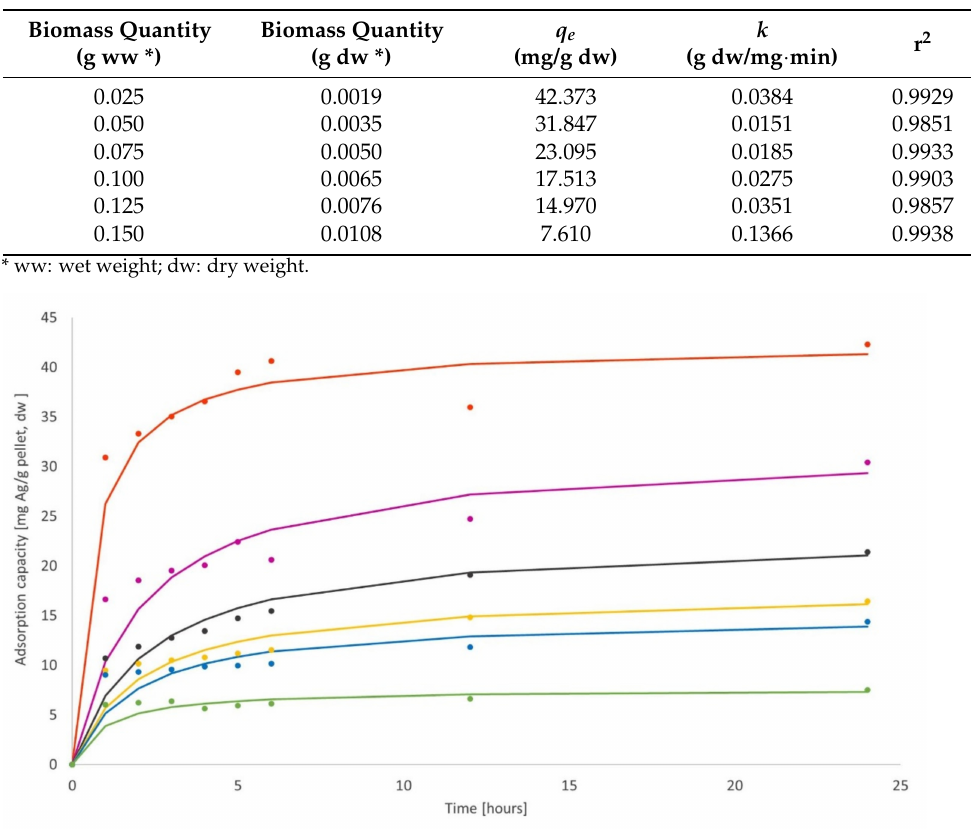
Table 2. Parameters of the pseudo-second-order model kinetic model adjusted to the Ag biosorption on different quantities of Aspergillus tabacinus pellets.